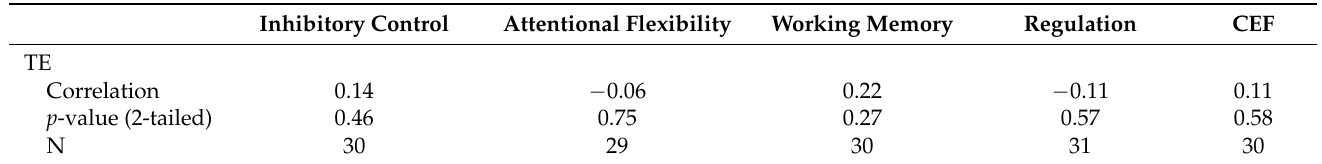
Table 4. Partial correlations between translation equivalents and EEFQ sub-scales controlling for age and parental education. Inhibitory Control Attentional Flexibility Working Memory Regulation